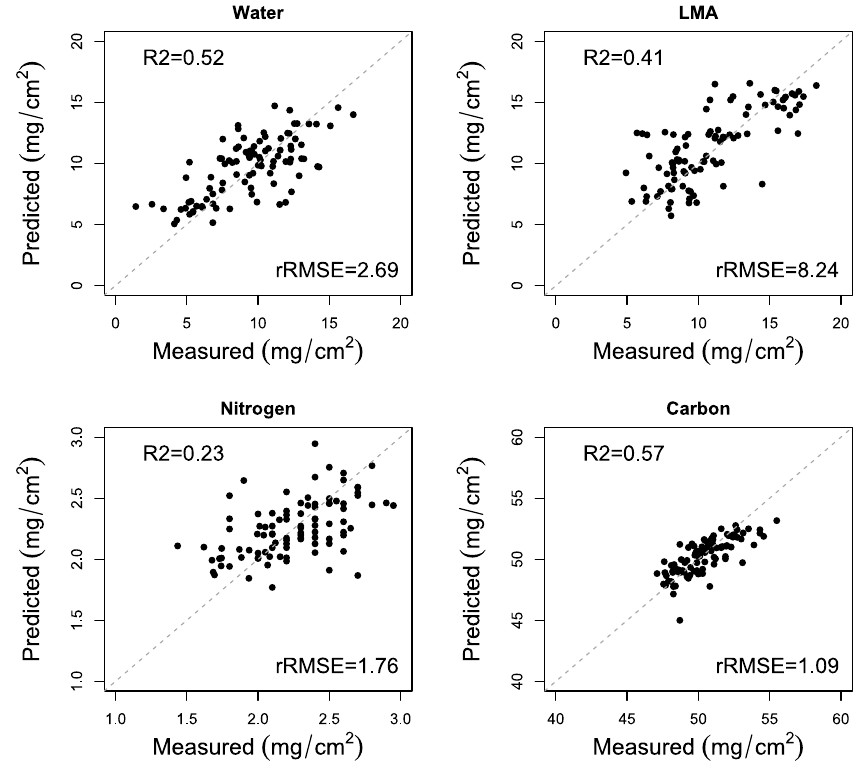
Figure 3. Comparisons between the measured and predicted traits in canopy PLSR validation model of sagebrush. The dashed line is 1:1 line.